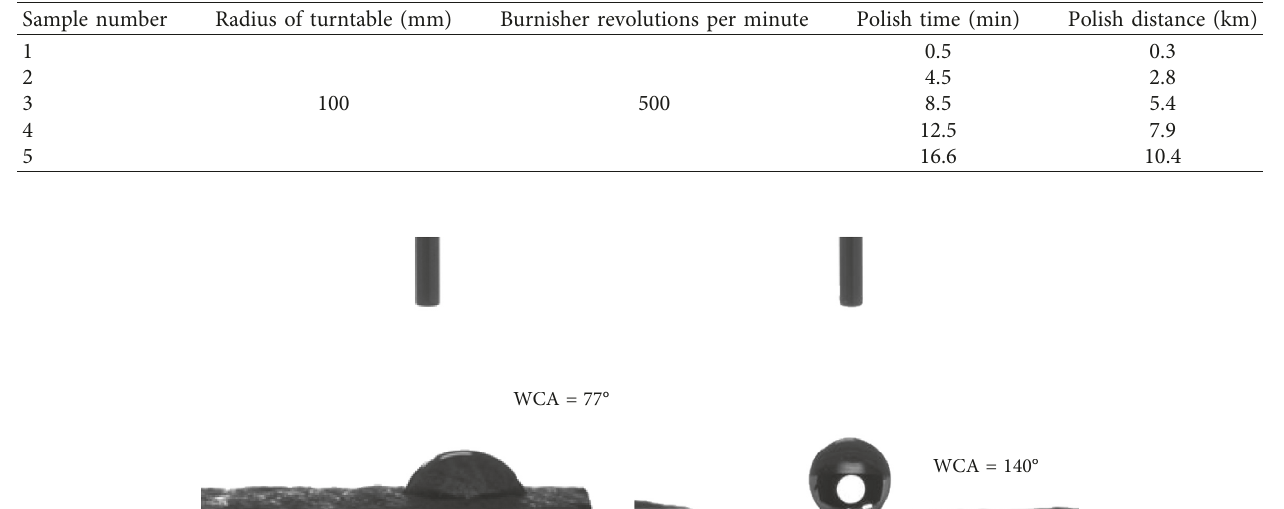
Table 3: Length reduction of the modified sample.